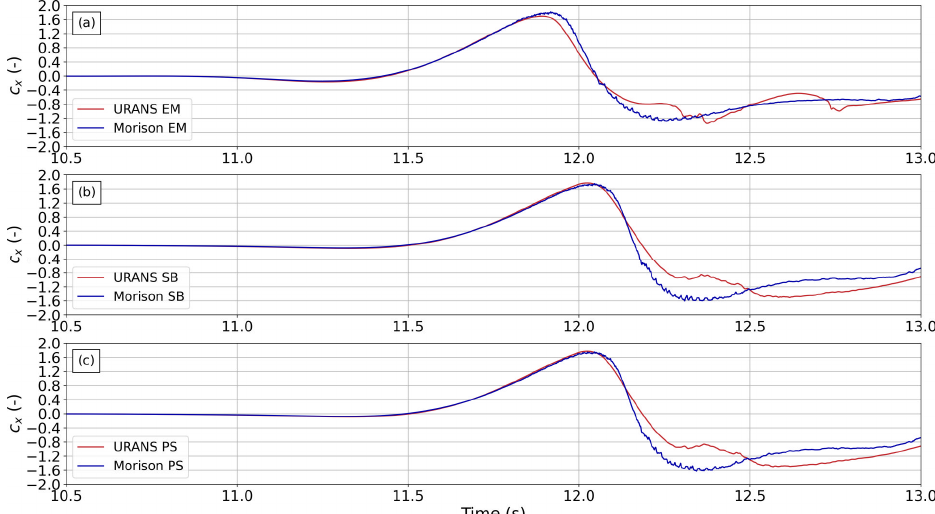
Figure 16. Time histories of load coefficient c x in scenario 2 for the medium-diameter upstream cylinder ( a ), for the medium-diameter downstream starboard cylinder ( b ), and for the medium-diameter downstream portside cylinder ( c ).